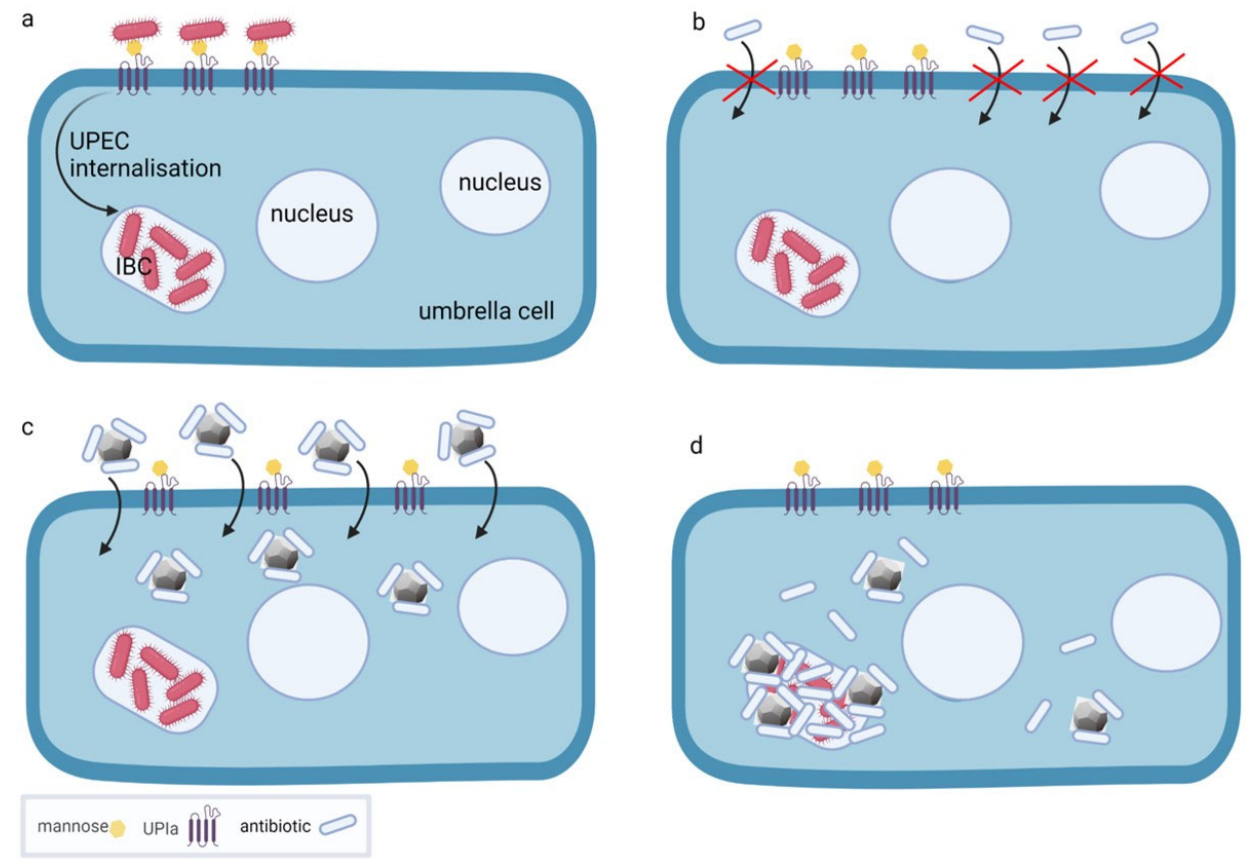
Figure 5. Possible mechanism for elimination of the intracellular bacterial community (IBC) of UPEC in superficial urothelial umbrella cells. ( a ) The apical plasma membrane of the umbrella cell has transmembrane proteins uroplakin Ia (UPIa) with four transmembrane domains and mannose units to which UPEC attach before entering the cell and forming IBC within the cell. ( b ) Antibiotics cannot penetrate the apical plasma membrane of the umbrella cell and therefore cannot reach and eliminate UPEC within the IBC. ( c ) Antibiotics bound to NDs can penetrate the apical plasma membrane of the umbrella cell. ( d ) Once inside the cell, the antibiotics reach the IBC, dissociate from the NDs and eliminate the intracellular reservoir of UPEC within the IBC. The illustration was created by the authors using the BioRender app.